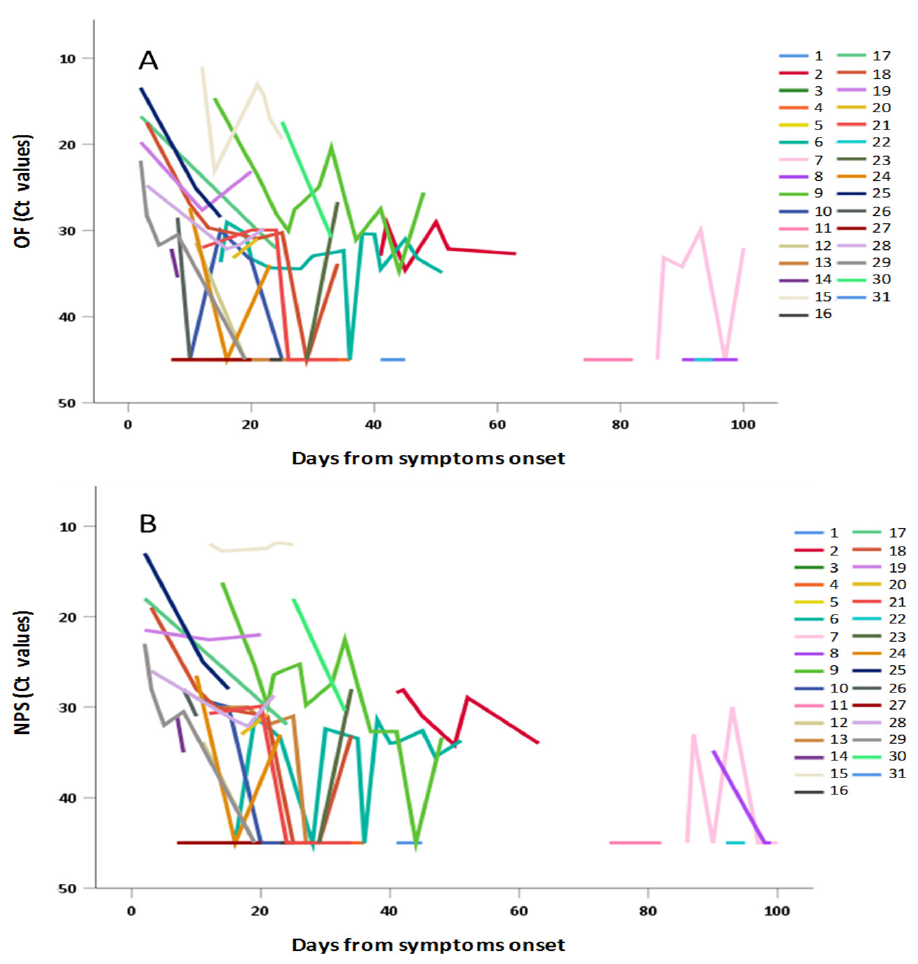
Figure 4. Shedding of SARS-CoV-2 RNA in ( A ) OF and ( B ) NPS samples from individuals with repeated measures, according to days from symptoms.